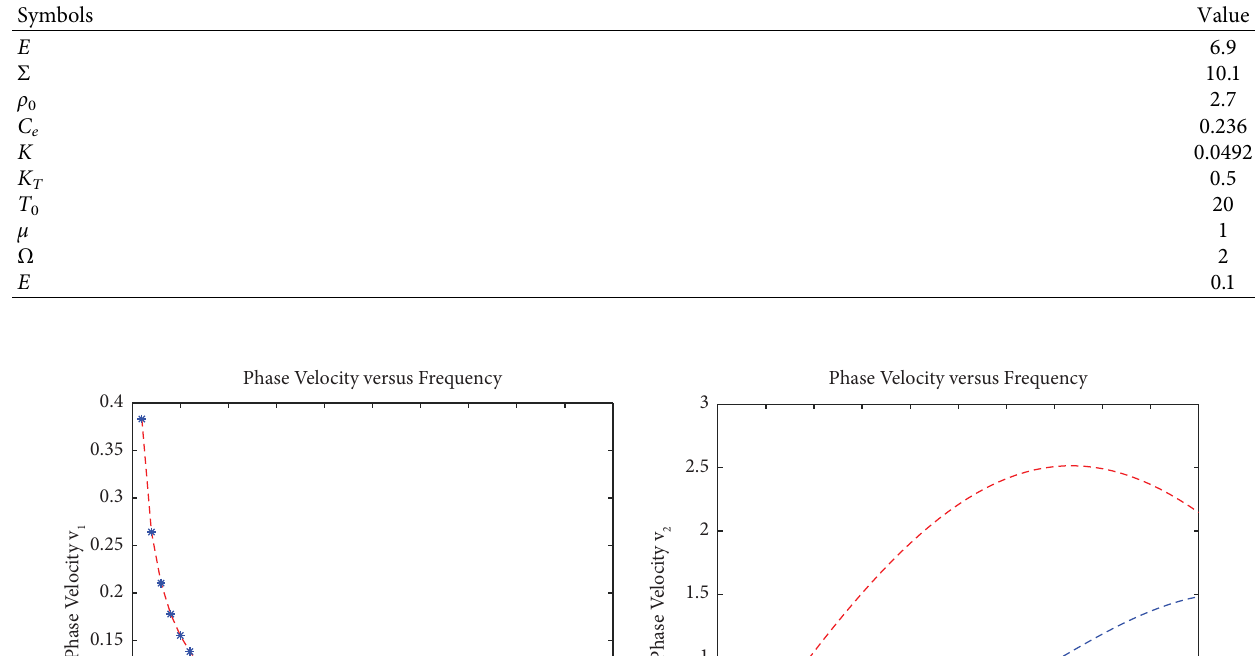
Table 1: Values of parameters.